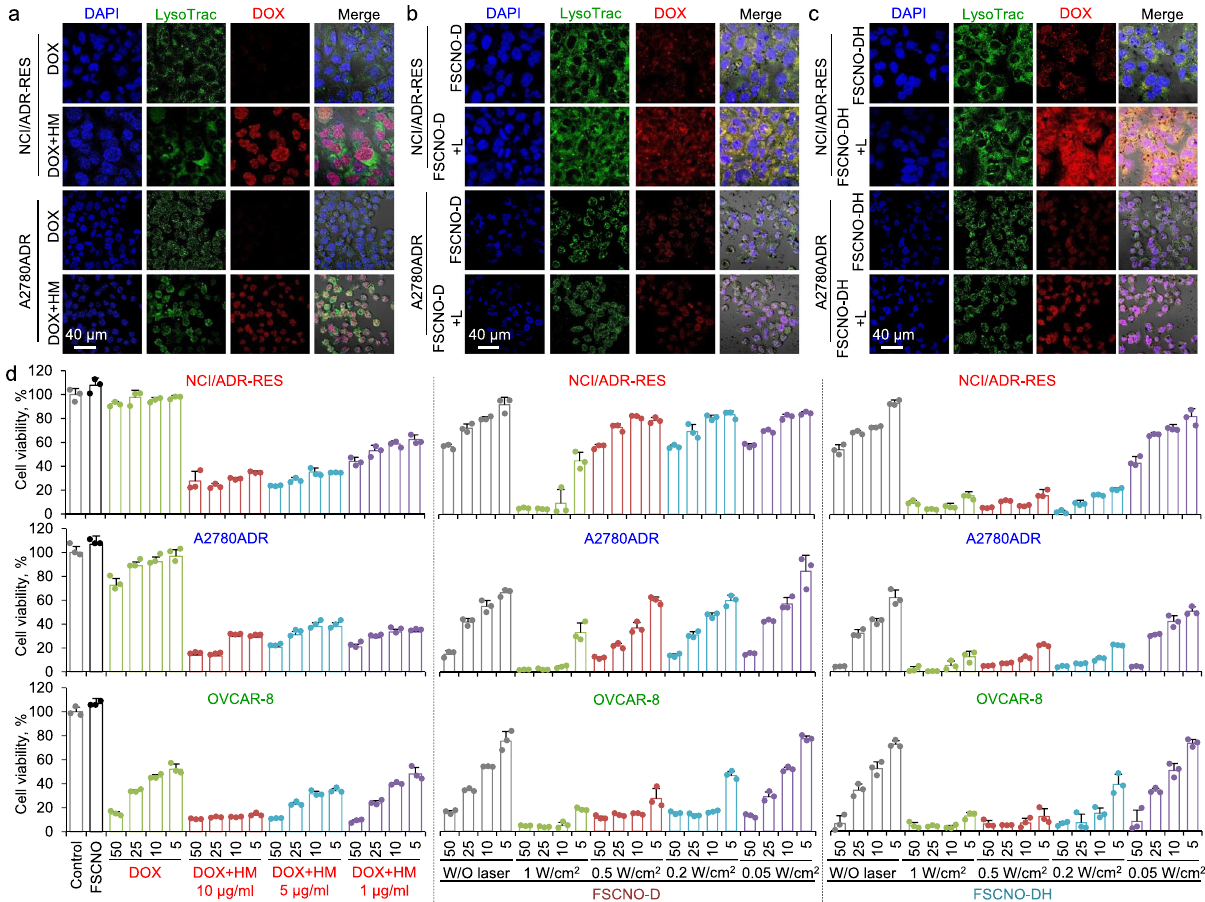
Fig. 4 Capacity of the FSCNO-DH nanoparticles in overcoming cancer drug resistance and killing drug-resistant cancer cells in vitro. a Confocal images of DOX in NCI/ADR-RES and A2780ADR multidrug-resistant cancer cells treated with free DOX or combined with HM (DOX + HM, 10 μ g ml − 1 for both DOX and HM). The data show that DOX can enter the multidrug-resistant cancer cells when combined with P-gp inhibitor (HM). LysoTrac: LysoTracker Green. b, c Confocal images of NCI/ADR-RES and A2780ADR multidrug-resistant cancer cells treated with FSCNO-D ( b ) or FSCNO-DH ( c ) nanoparticles without or with NIR laser (L) irradiation (FSCNO-D + L or FSCNO-DH + L, 0.5 W cm − 2 for 1 min). The data show that most of the DOX are distributed in the cytosol for cells treated with FSCNO-D with or without laser irradiation and FSCNO-DH nanoparticles in the absence of NIR laser irradiation while DOX overlaps with DAPI in the cell nuclei for cells treated with FSCNO-DH nanoparticles after irradiated with laser. d NCI/ADR-RES, A2780ADR, and OVCAR-8 cancer cells treated with free DOX; free DOX combined with HM at concentrations of 1, 5, and 10 μ g ml − 1 ; FSCNO-D or FSCNO-DH nanoparticles without or with NIR laser irradiation of different powers for 2 min. The data show that HM is crucial to enhance the anticancer effect of DOX in either free DOX or DOX-laden FSCNO nanoparticles. Error bars represent ± s.d. ( n = 3 independent